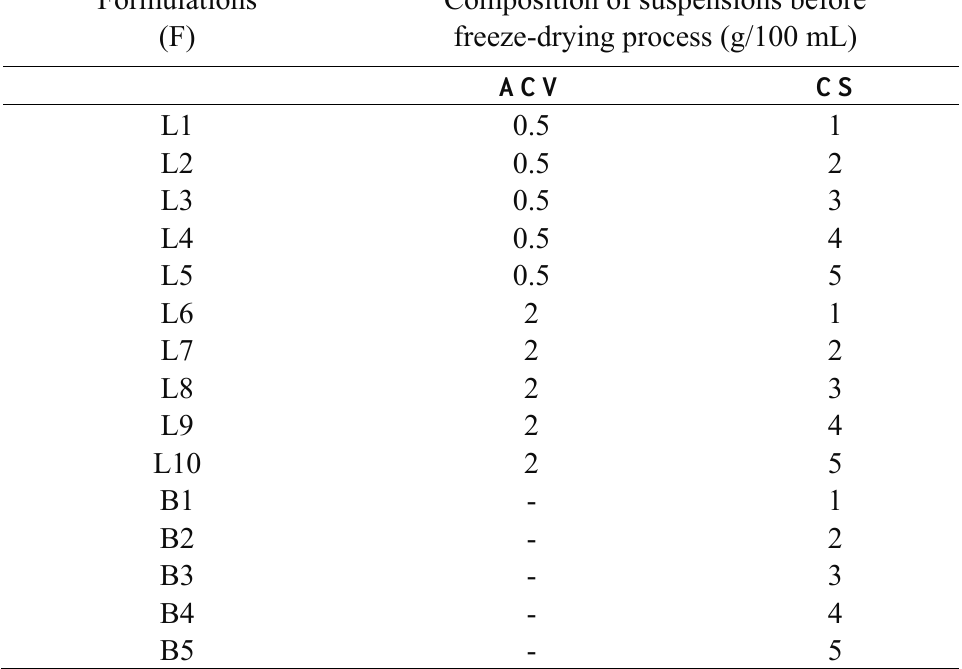
Table 1. Proportions of acyclovir (ACV) and chitosan (CS) in suspensions used to manufacture lyophilized